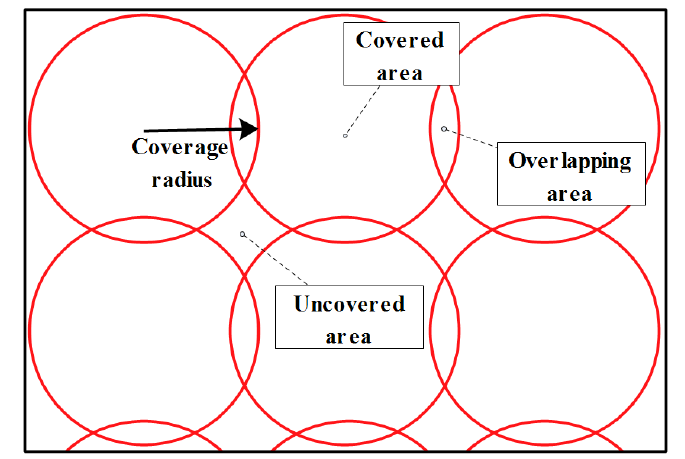
Figure 5. The used coverage mode (moderate mode)